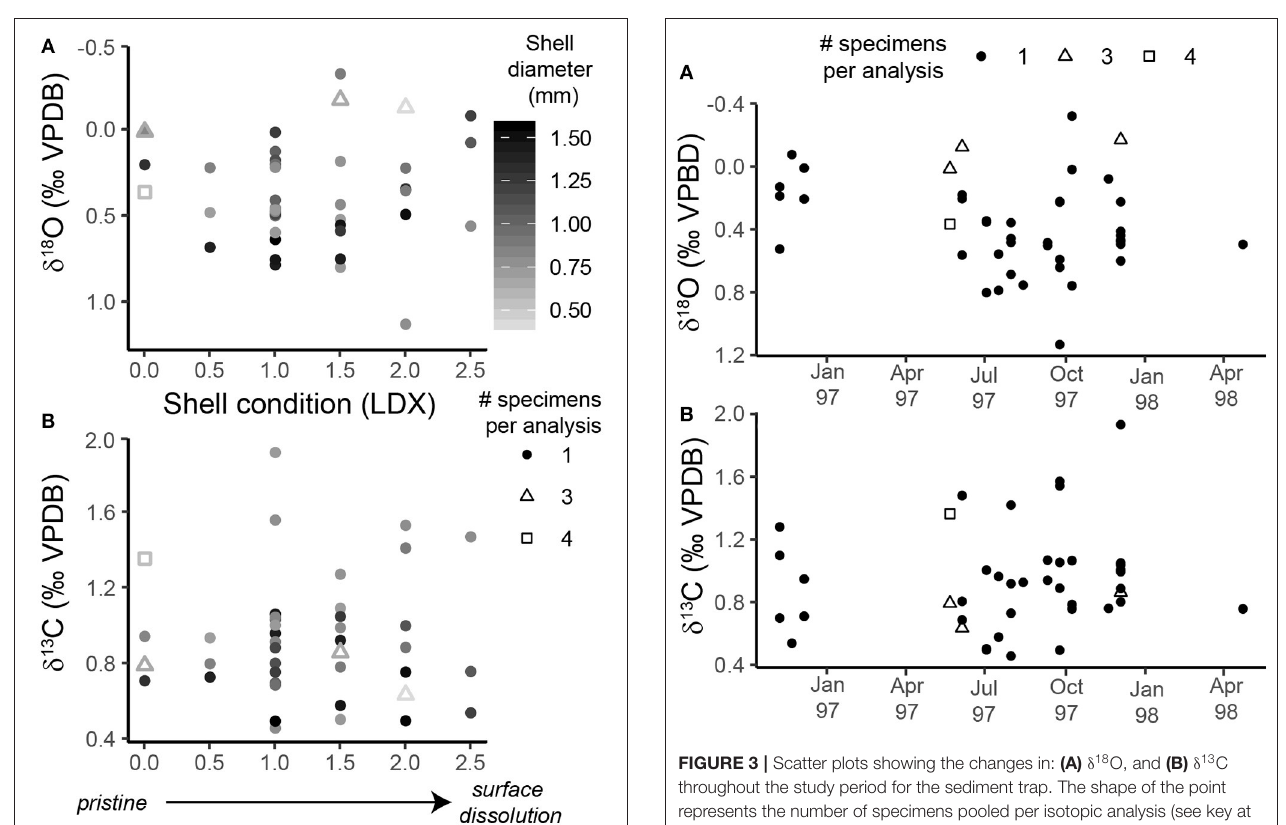
δ 13 C of shell material ( δ 18 O trap : p = 0.791, R 2 = 0.002; δ 13 C trap : p = 0.944, R 2 = 0.0001; δ 18 O